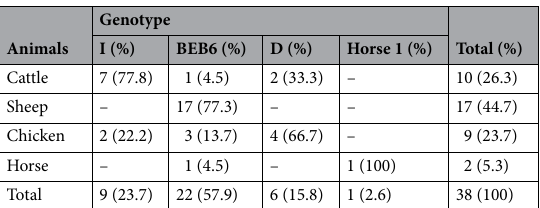
Table 2. The genotype distribution of E. bieneusi among